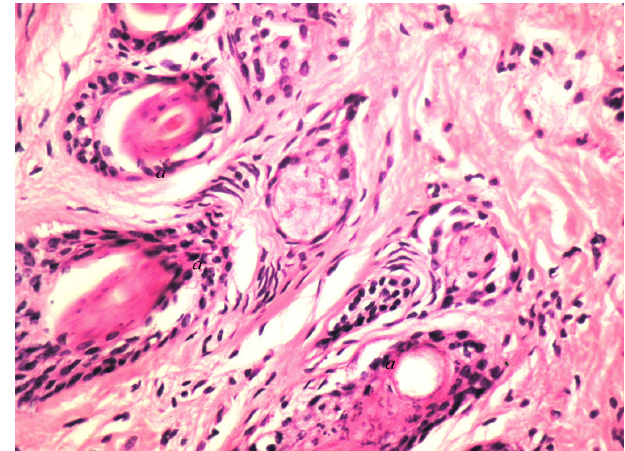
Fig. 3. Histological structure of guinea pig skin on the 21st day of treatment: a-epithelium of hair follicles. Hematoxylin and eosin. EG. 10, vol.